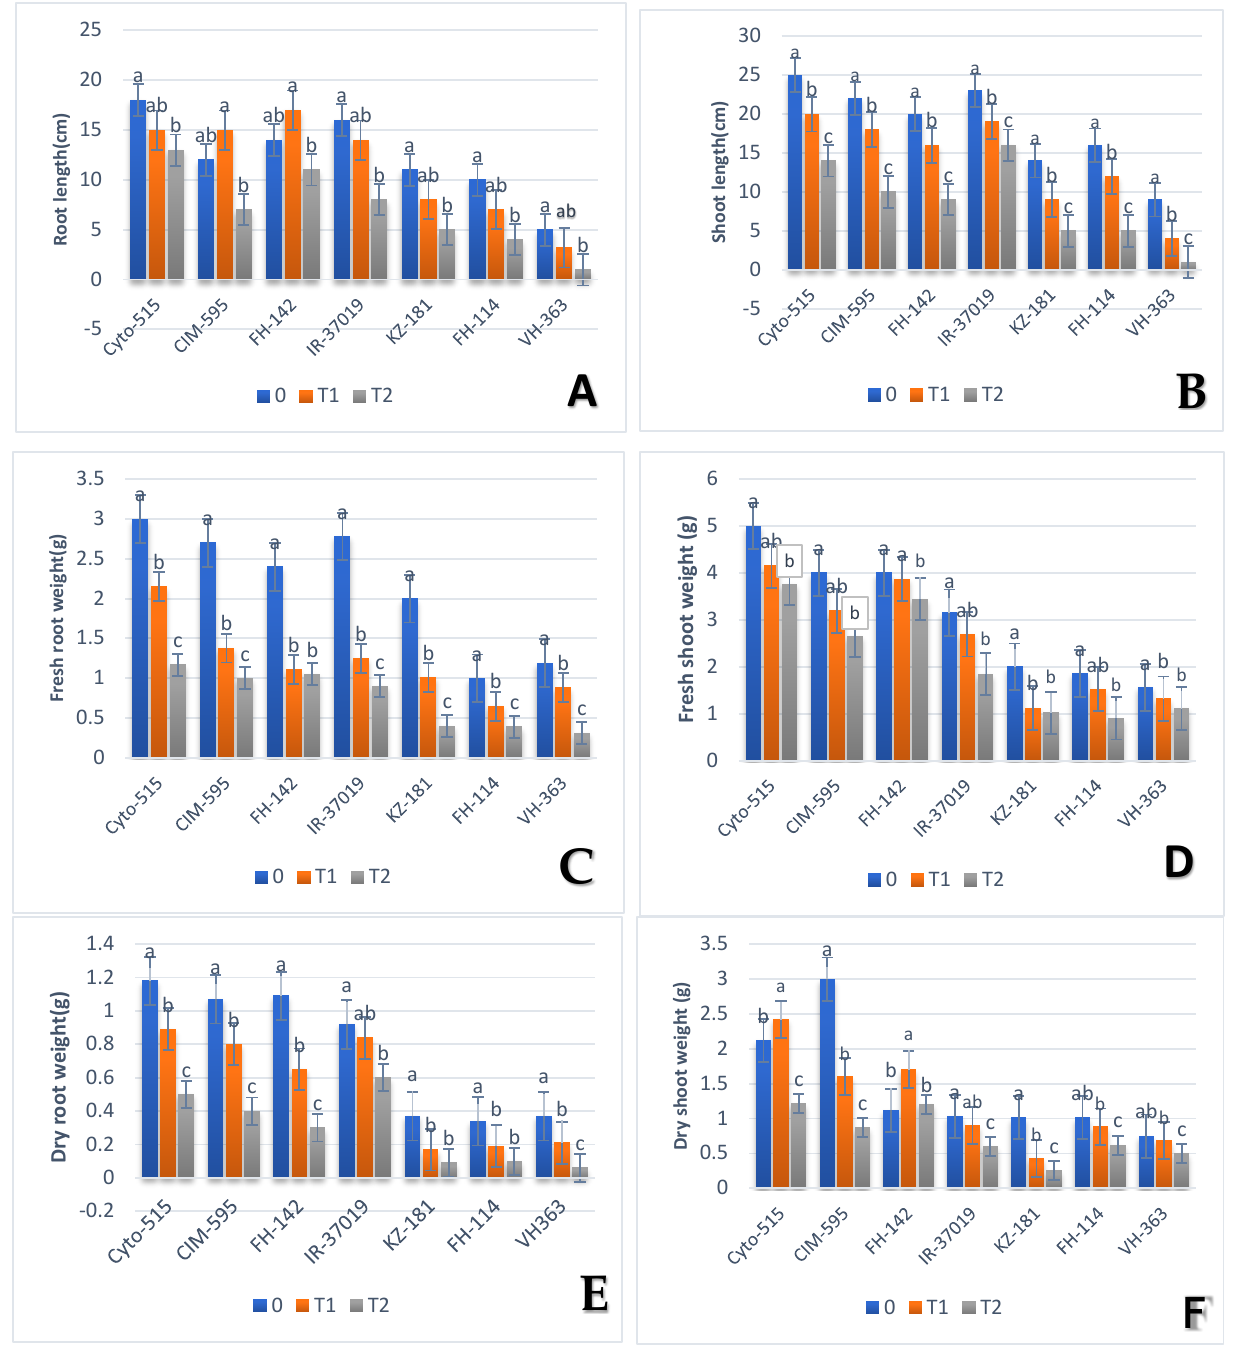
Figure 3- Effect of drought stress on morphological traits of drought-tolerant and susceptible gen- otypes of cotton ( A ) Root length, ( B ) Soot length, ( C )Fresh root weight), ( D ) Fresh shoot weight, ( E ) Dry root weight, ( F ) Dry shoot weight. Treatments: T0 = Control, T1 = 75% water stress, T2 = 50% water stress, and bars with the different lettering showed significant differences while the same lettering bars showed non-significant differences between these genotypes.